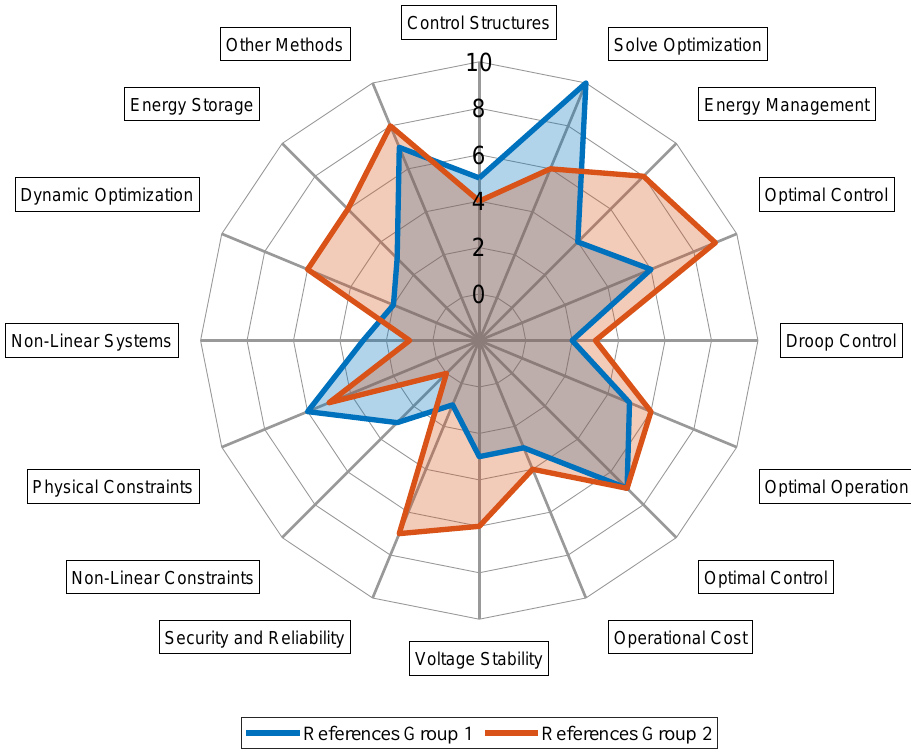
Figure 5. Research orientation based on the state of the